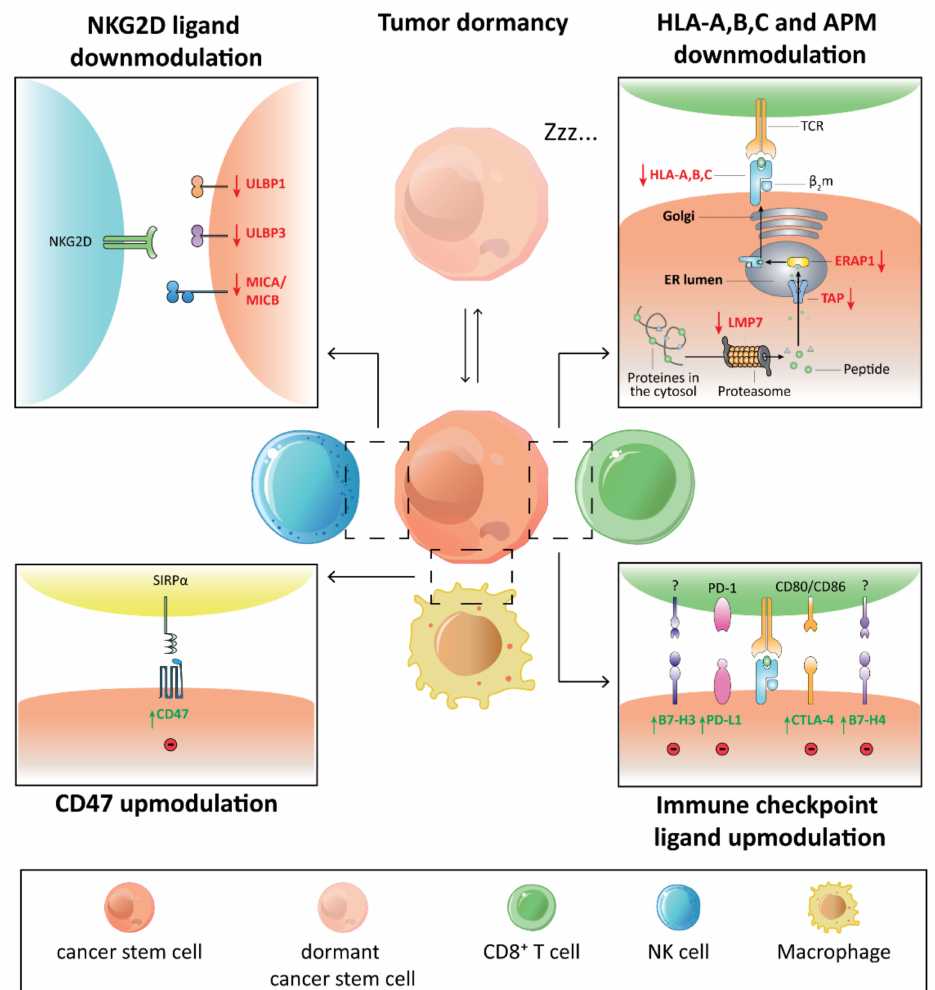
Figure 1. Immune escape mechanisms of CSCs. Cancer stem cells (CSCs) adopt several tricks to escape immune control. First, CSCs avoid the recognition by CD8 + T cells by reducing the human leukocyte antigen-A, B, C (HLA-A, B, C) and the antigen processing machinery (APM) molecule expression. Second, CSCs impair the cytotoxicity of natural killer (NK) cells by downregulating the natural killer group 2D (NKG2D) ligand expression. Third, the ligation of immune checkpoint ligands such as programmed death-ligand 1 (PD-L1), cytotoxic T-lymphocyte antigen-4 (CTLA-4), B7 homolog 3 (B7-H3) and B7 homolog 4 (B7-H4) expressed by CSCs to their respective receptors on T cells decreases their proliferation and interferon- γ (IFN- γ ) production or leads to apoptosis. Fourth, CSCs upmodulate the “don’t eat me” signal CD47 that blocks their phagocytosis through the interaction with the membrane glycoprotein signal regulatory protein α (SIRP- α ) expressed on the surface of macrophages (M ϕ s). Fifth, CSCs acquire a state of dormancy by entering into a G0 phase of cell cycle arrest. The cancer dormancy protects CSCs from immune control, ensuring their survival and eventually their metastatic